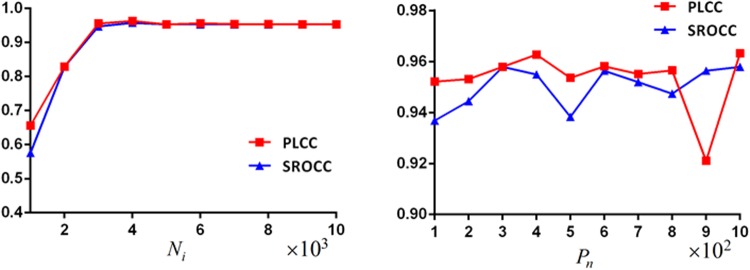
CNN prediction performance with
Ni or
Pn changes.